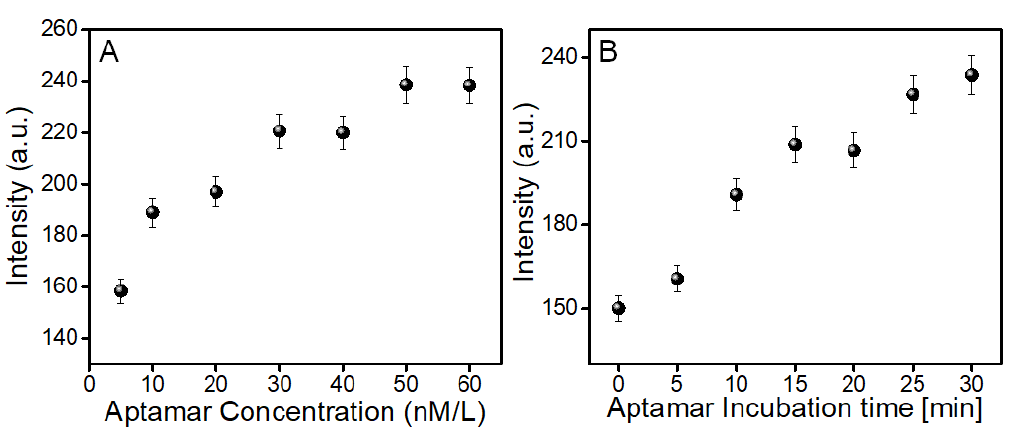
Figure 7. Effect of aptamer concentrations (5 to 60 nM) ( A ) and aptamer incubation time (0–30 min) ( B ) on fluorescence recovery of Rh-B (160 ng/L) in the presence of ZnSe-B6 (450 µ g/L).